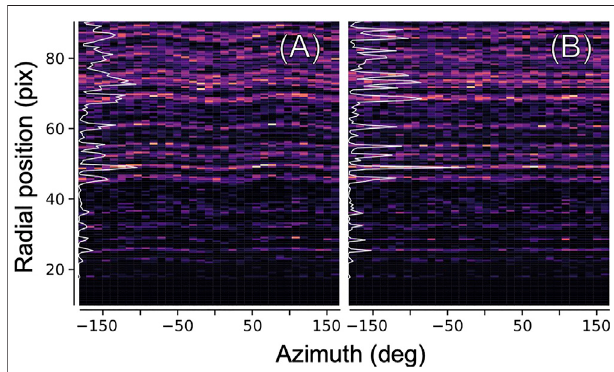
FIGURE 5 | Ellipticity re fi nement. In order to correct for the elliptical distortion of diffraction patterns introduced by electron optics, we histogramize all found diffraction peaks (from all images) in two-dimensional polar coordinates. (A) Elliptical distortion manifests itself in a modulation of the position of major features near the inverse layer spacings of the crystal. Azimuthal integration into a radial pro fi le (white line) yields a blurred, low- contrast pattern (B) Same, after correcting the positions of the peaks according to an elliptical model before